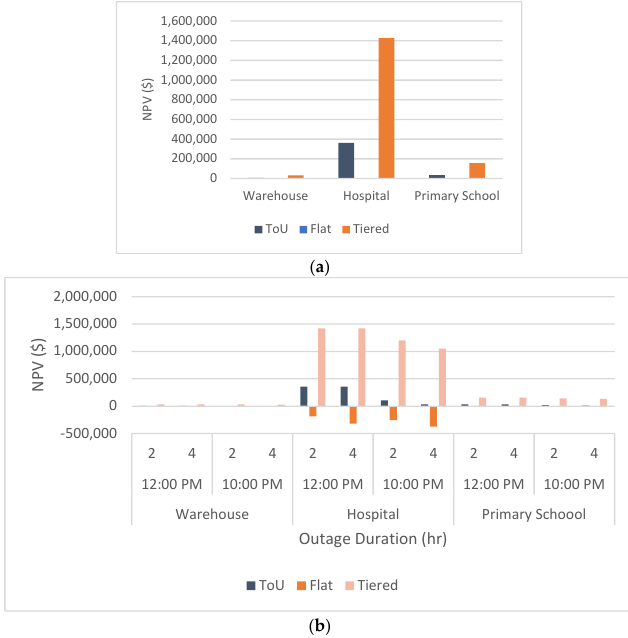
Figure 4. Kansas City, MO region—( a ) financial and ( b ) resilience results. Table 3. Positive NPV results for the commercial loads in the Kansas City, MO